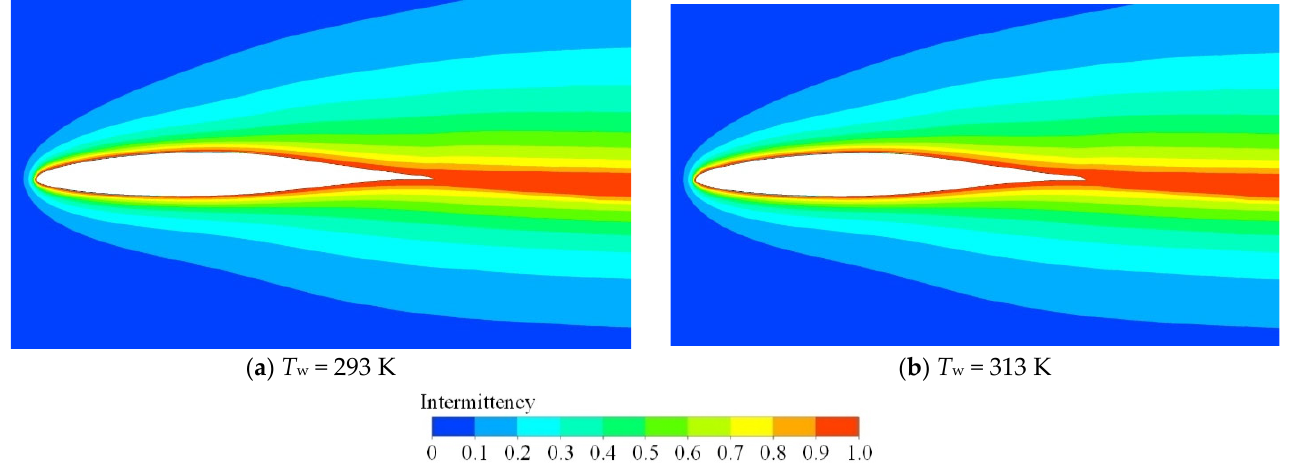
Figure 12. Influence of surface temperature on distribution of intermittency ( ε = 0.5%, α = 0°, Ma = 0.7).